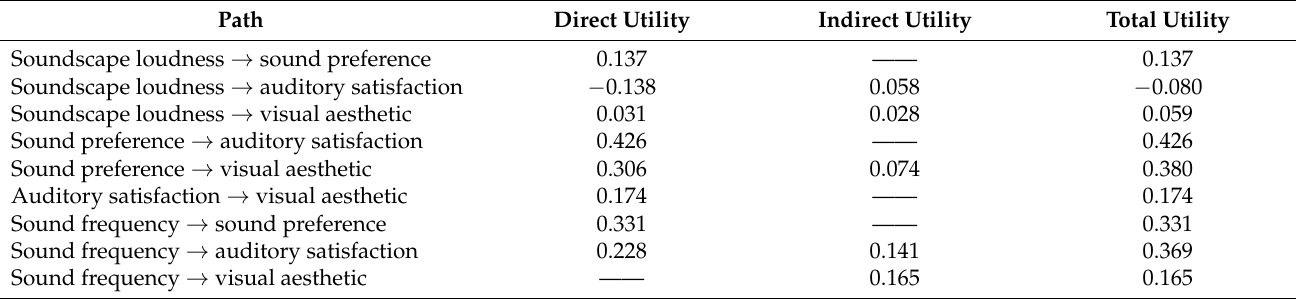
Table 6. Effects of soundscape perception on visual